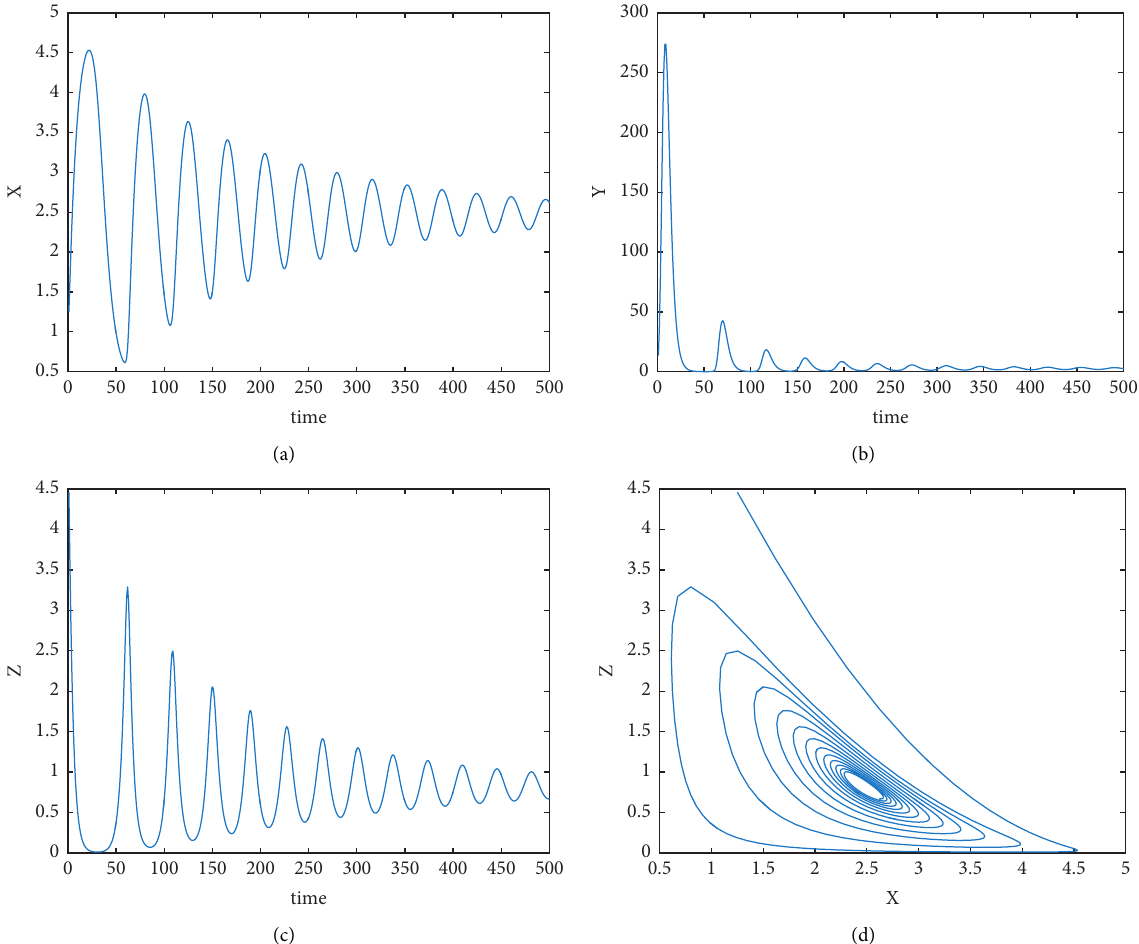
Figure 3: (a)–(d)) Dynamic of chemicals involved in bone formation process obtained through fractional model of bone remodeling process by Caputo and